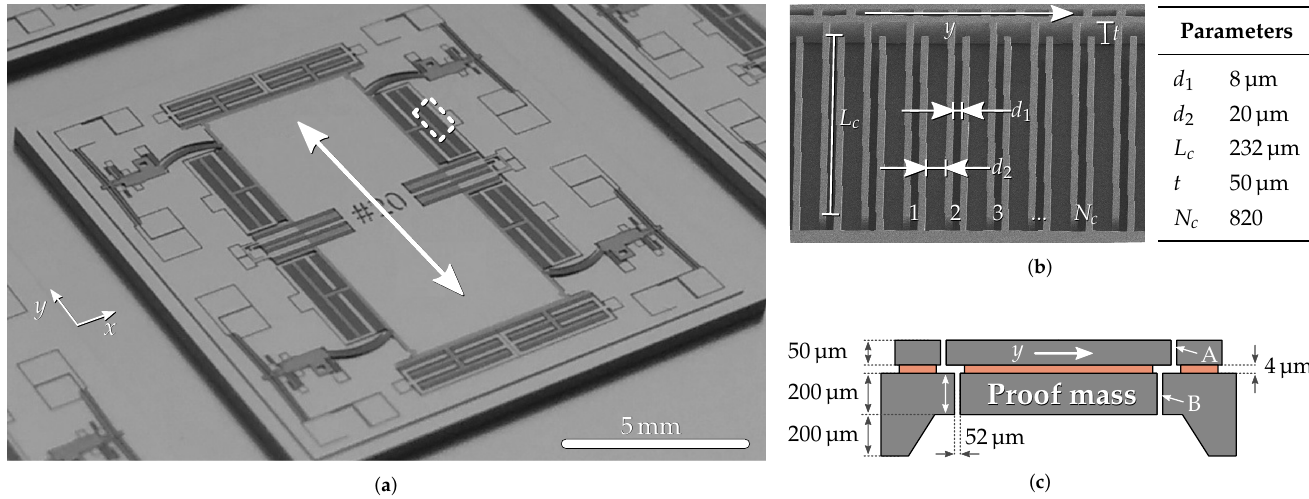
Figure 1. ( a ) Photograph of the MEMS accelerometer for which the gas damping is modeled. The central 12.7mg proof mass can move along the y-direction as indicated by the arrow. ( b ) An electron microscope zoom-in of part of the MEMS sensing capacitors indicated by the boxed area in ( a ) along with the nominal etched dimensions. The edge of the proof mass is visible at the top of the image and can move along the indicated y-direction. ( c ) Schematic cross-section of the accelerometer. Significant squeezed-film damping occurs both in the capacitor structures in the top silicon layer (A) and in the bottom silicon layer